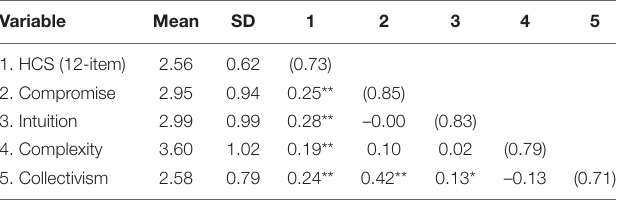
TABLE 4 | Study 2 – correlation analysis of the 12-item HCS. Variable